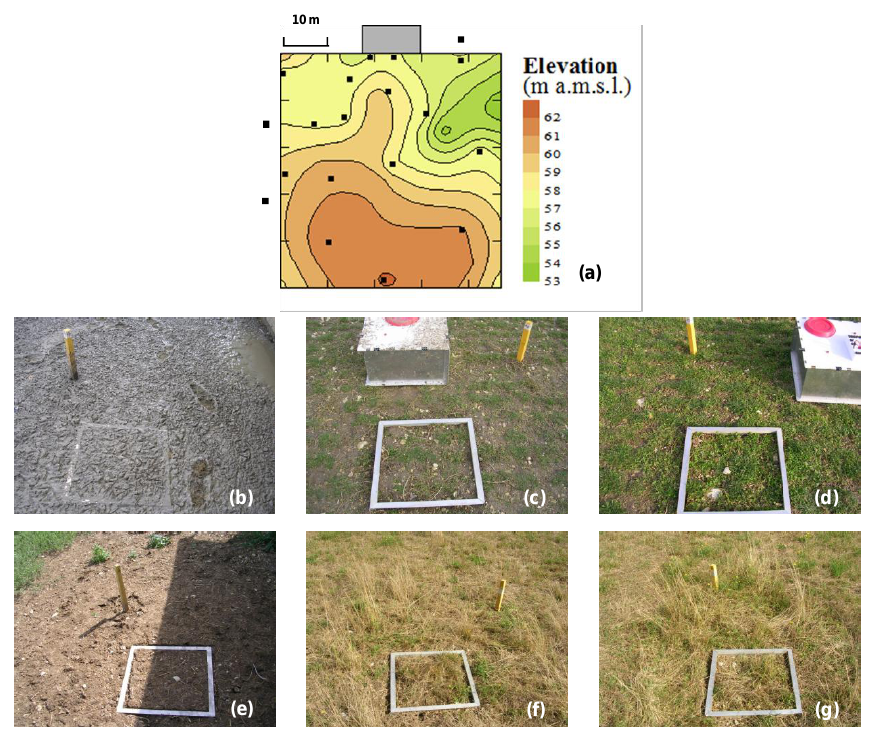
Fig. 1. (a) Site map showing the approximately square-shaped fenced-in outdoor run (50 × 47m), the broiler house (grey rectangle at the top), the topography of the outdoor run, and the distribution of the static chambers (black square). (b–g) Photographic records of the state of soil and vegetation, showing differences in soil moisture, vegetation density and soil compaction for chamber frames located at 5m (b, e) , 24m (c, f) and 41m (d, g) from the broiler house. Pictures were taken on 2 March 2010 (b–d) and on 27 July 2010 (e–g) , a.m.s.l.=above mean sea level. Table 1. Main characteristics of the two broiler batches during which GHG fluxes were measured. Batch Number of animals Weight at slaughter Dates at start at slaughter (kg/broiler) Chicks arrival First outdoor access Slaughter